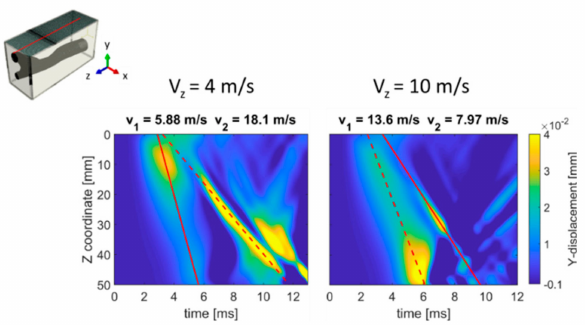
Figure 10. TOF plots at the lumen surface for the CA model under traveling impulse condition (V z of 4 and 10 m / s). For both figures the wave speeds of the main (V 1 ) and secondary (V 2 ) travelling waves are indicated by the dashed and solid lines,